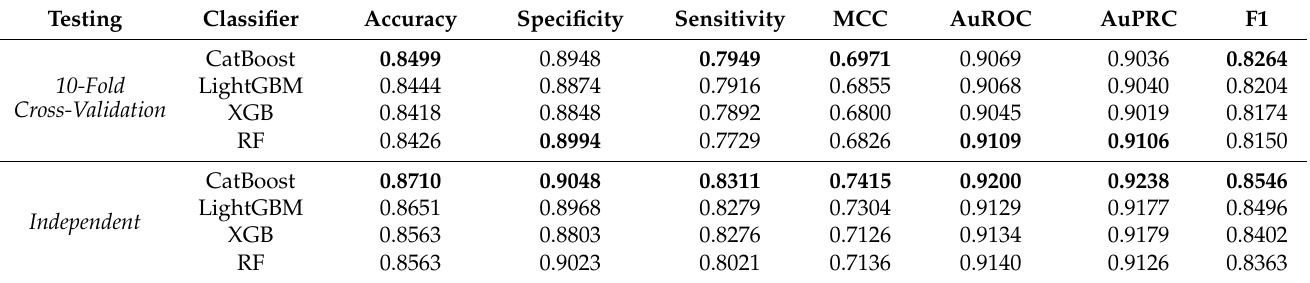
Table 4. Comparison of Different Classifiers on Selected Features from Mordred feature Descriptor. (Bold values represent high performance).